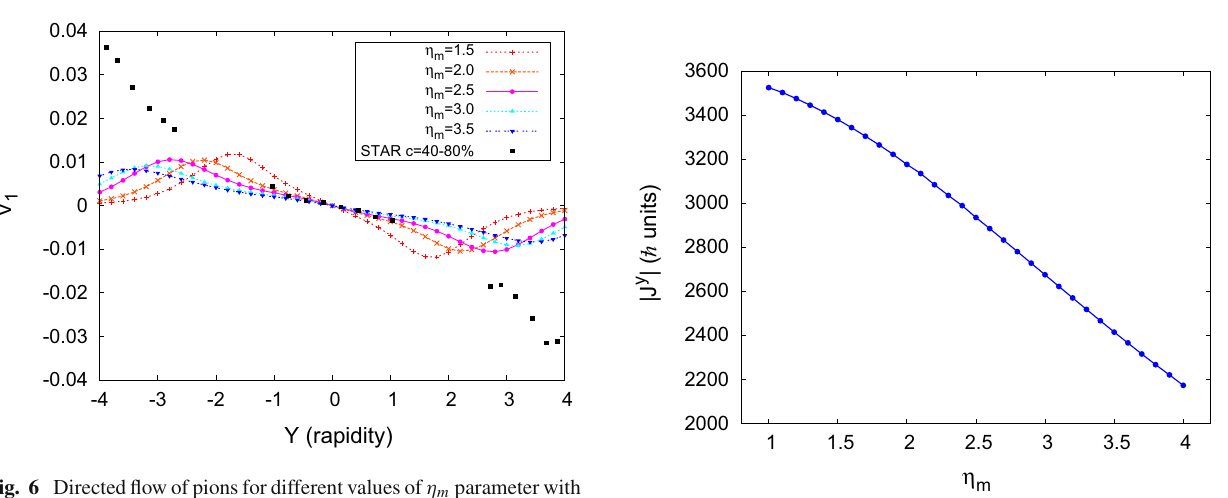
Fig. 6 Directed flow of pions for different values of η m parameter with η/ s = 0 . 1 compared with STAR data [1]